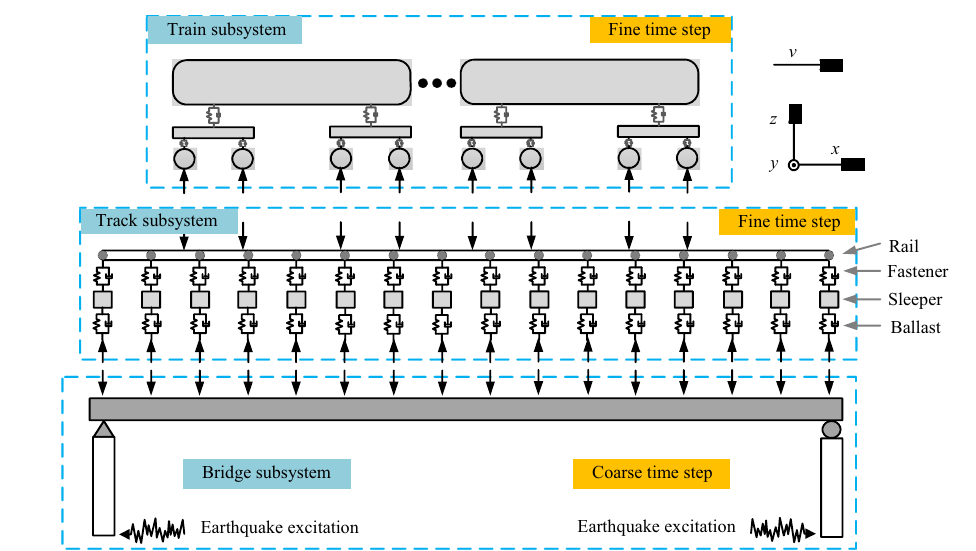
Fig. 1 The train–track–bridge coupled system under earthquake excitation